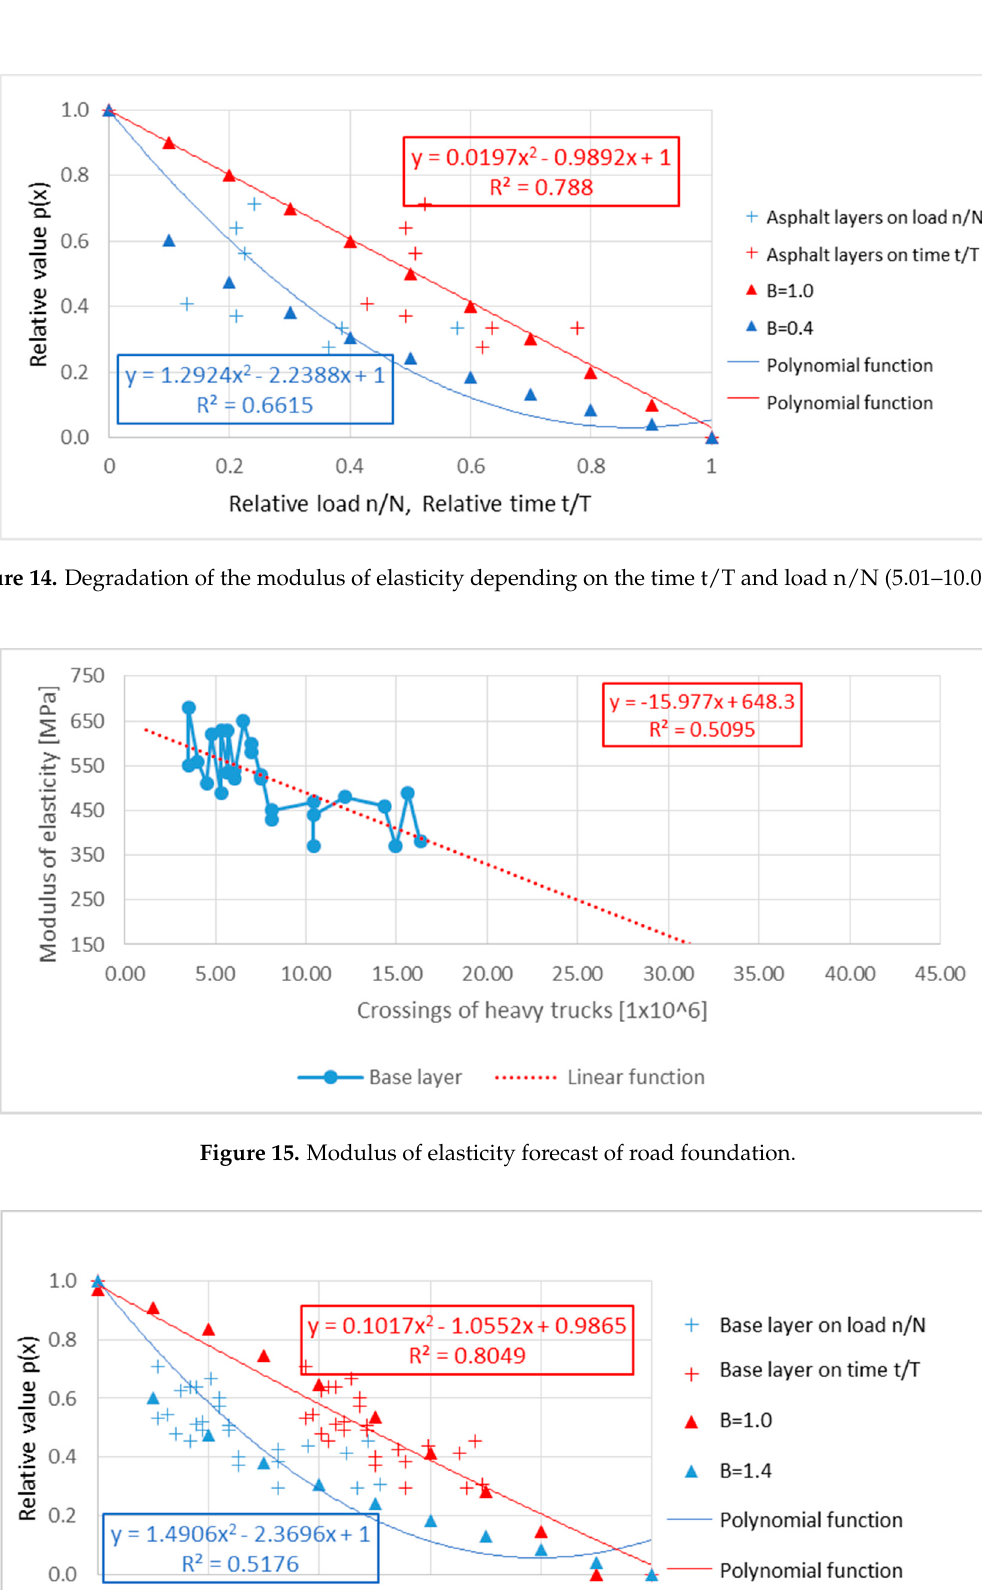
Figure 13. Degradation of the modulus of elasticity depending on the time t/T and load n/N (10.01 –20.00 °C).